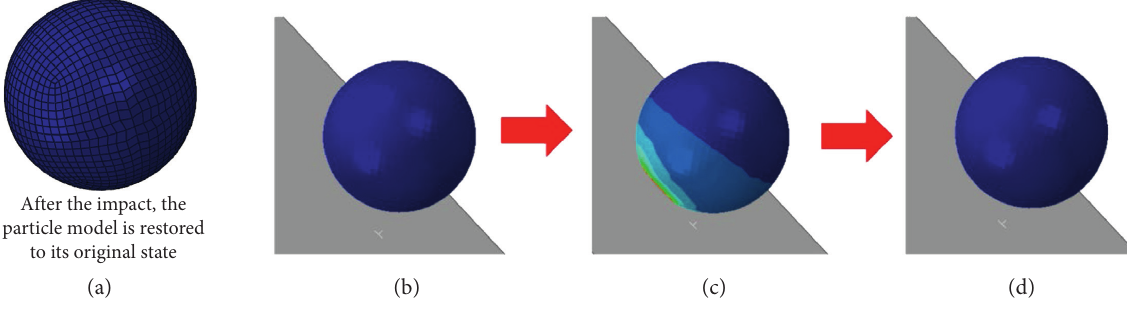
Figure 8: Impact effect diagram of Model 1.